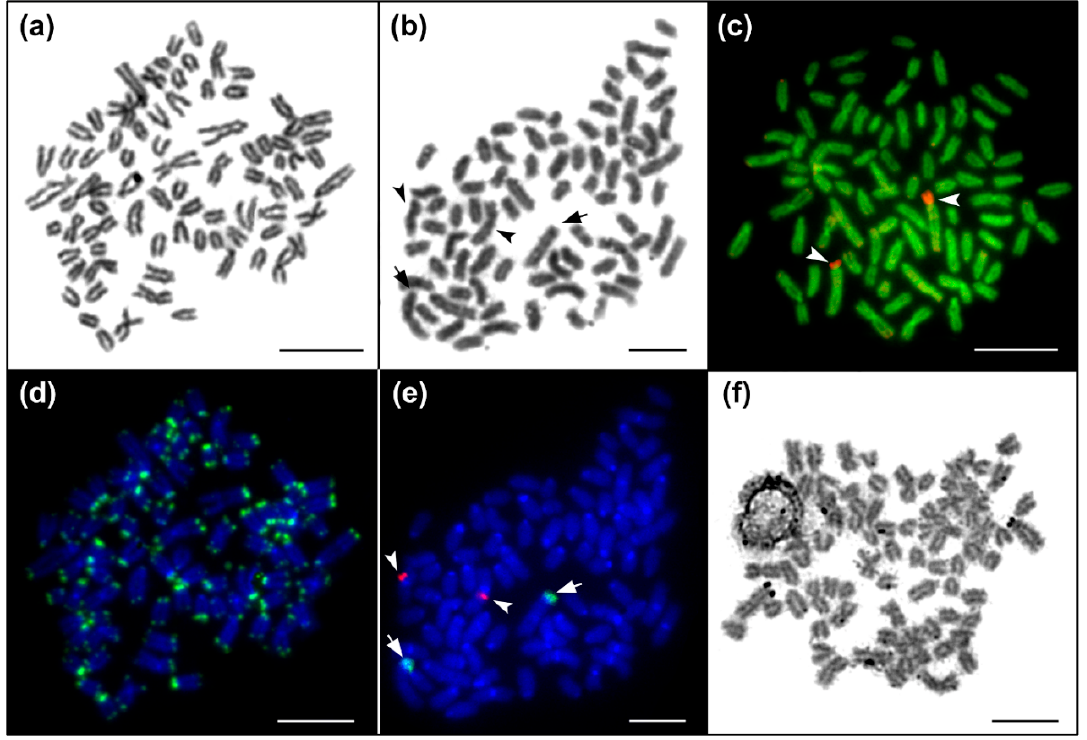
Figure 2. Chromosome analyses of Salmo platycephalus. (a, b ) Giemsa-stained metaphases corresponding to ( d , e ) panels; ( c ) DAPI/ CMA 3 fluorescence, DAPI stained chromosomes (green), CMA 3 signals of GC-rich regions (red); ( d ) DAPI stained chromosomes (blue), telomere repeat hybridization signals (green); ( e ) DAPI stained chromosomes (blue), 28S rDNA (green, indicated by arrows), 5S rDNA hybridization signals (red, indicated by arrowheads); ( f ) Ag-NOR impregnation showing the active major rDNA unit corresponding to the 28S rDNA sites. Bar equals 10 μ m.